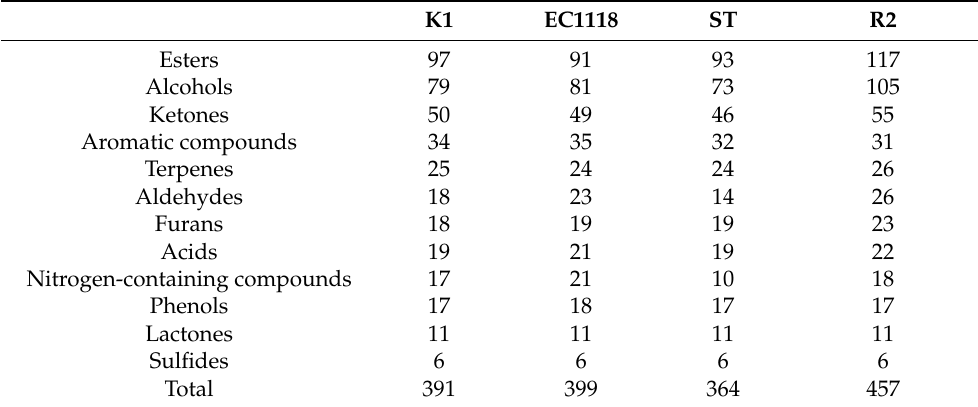
Table 2. Volatile compounds in Vidal icewine fermented by different